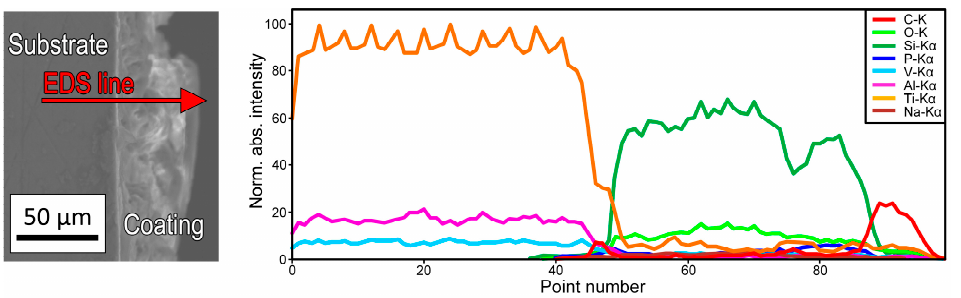
Figure 5. The cross-sectional microstructure of MAO coating (0.5 GO), and the element distribution along the marked line.